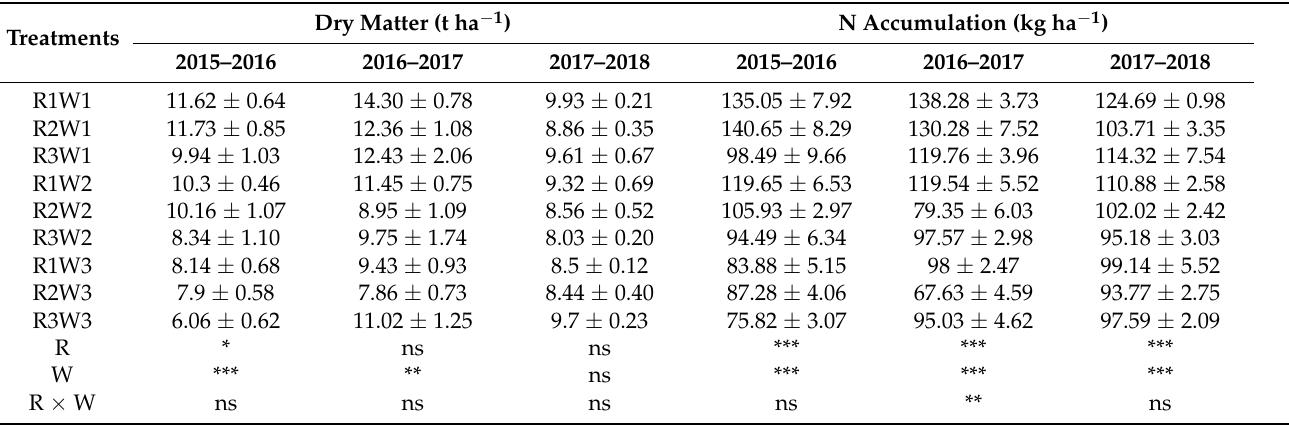
Table 3. Dry matter accumulation and N accumulation at maturity under different N rates in three wheat seasons